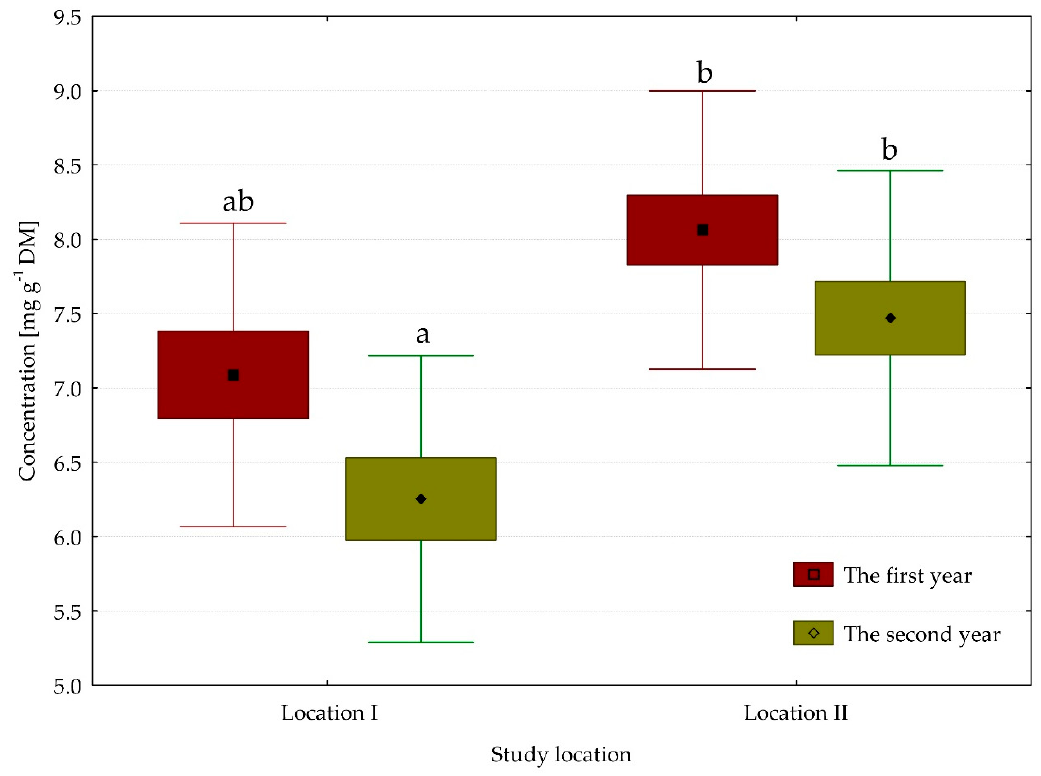
Figure 1. Chlorophyll a content in Melica nutans leaf blades from two natural forest stands.